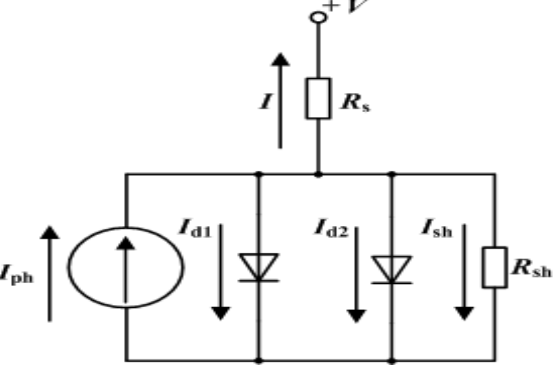
Figure 2. Double diode model of solar